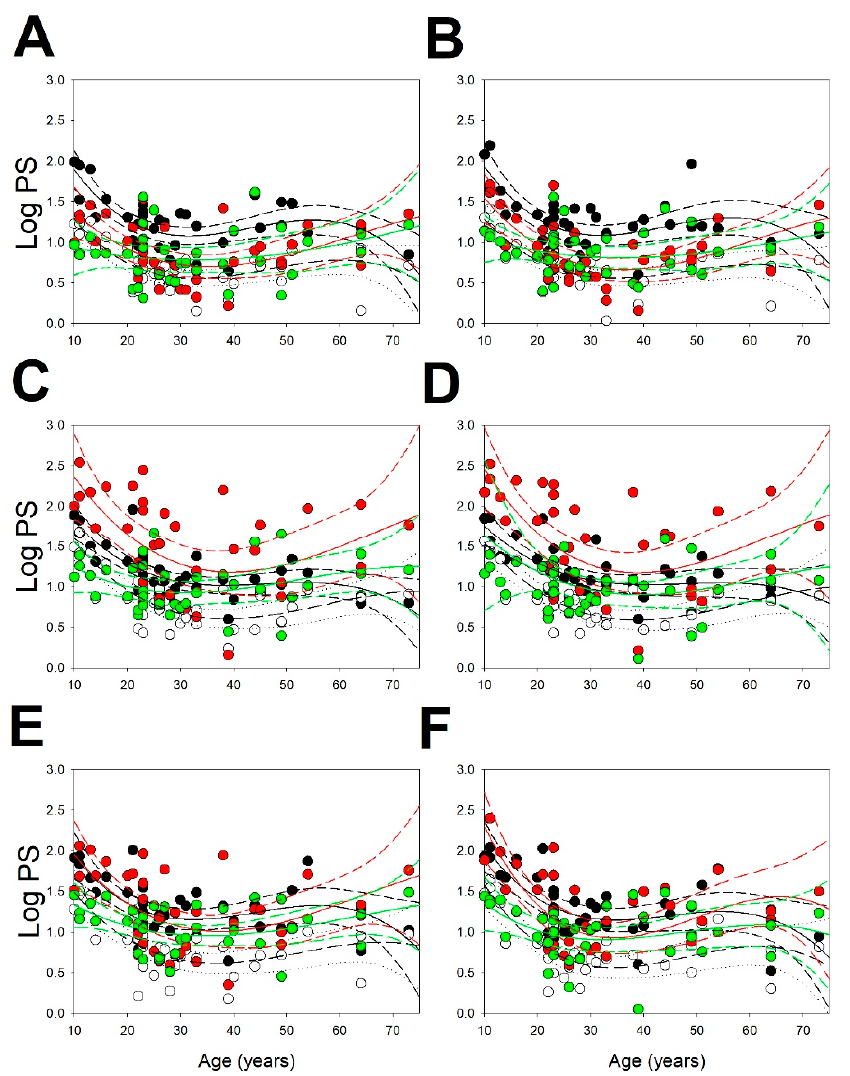
Figure 1. Scatter plots for logPS as function of age. ( A ) Left frontal lobe; ( B ) right frontal lobe; ( C ) left parieto-occipital lobe; ( D ) right parieto-occipital lobe; ( E ) left temporal lobe; and ( F ) right temporal lobe: Black dots = delta band; white dots = theta band; red dots = alpha band; and green dots = beta band. Black and short dashed lines = regression function and 95% interval coefficient for delta; medium dashed and dotted lines = regression function and 95% interval coefficient for theta; red solid and dashed lines = regression function and 95% interval coefficient for alpha; and green solid and dashed lines = regression function and 95% interval coefficient for beta.